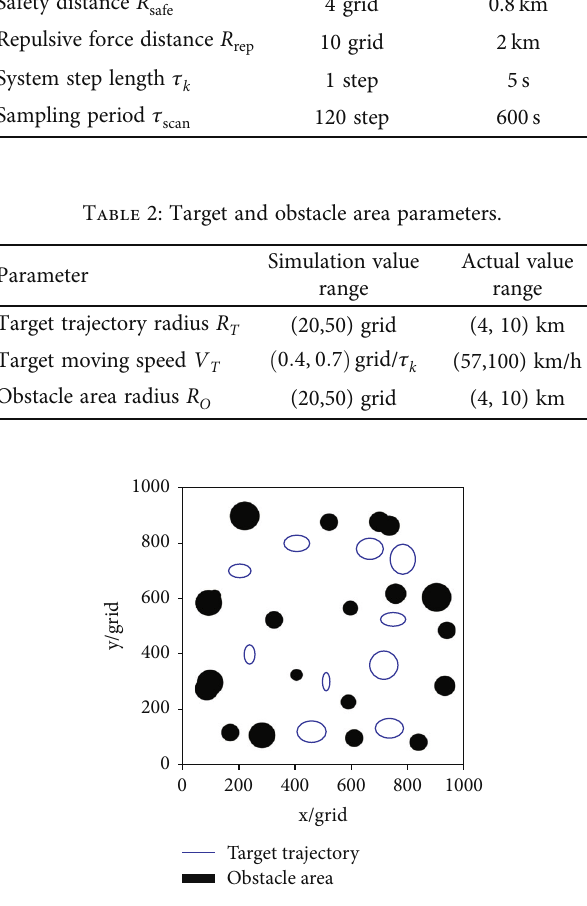
Figure 2: Unknown dynamic target trajectory and obstacle area distribution